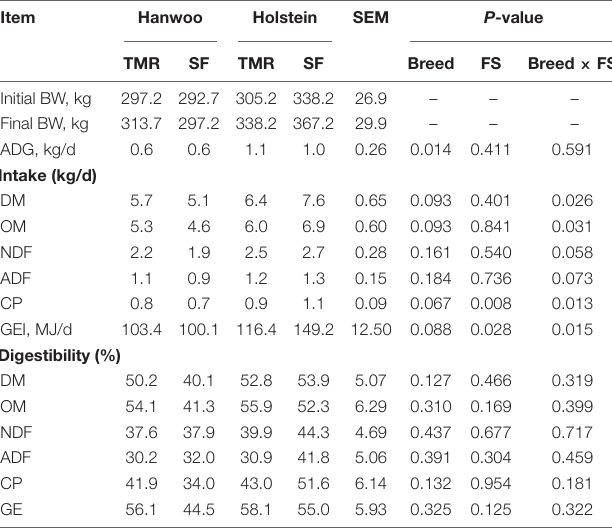
TABLE 3 | Least square means of body weight, nutrient intake and apparent total tract digestibility (%) of Hanwoo and Holstein steers fed by the TMR and SF